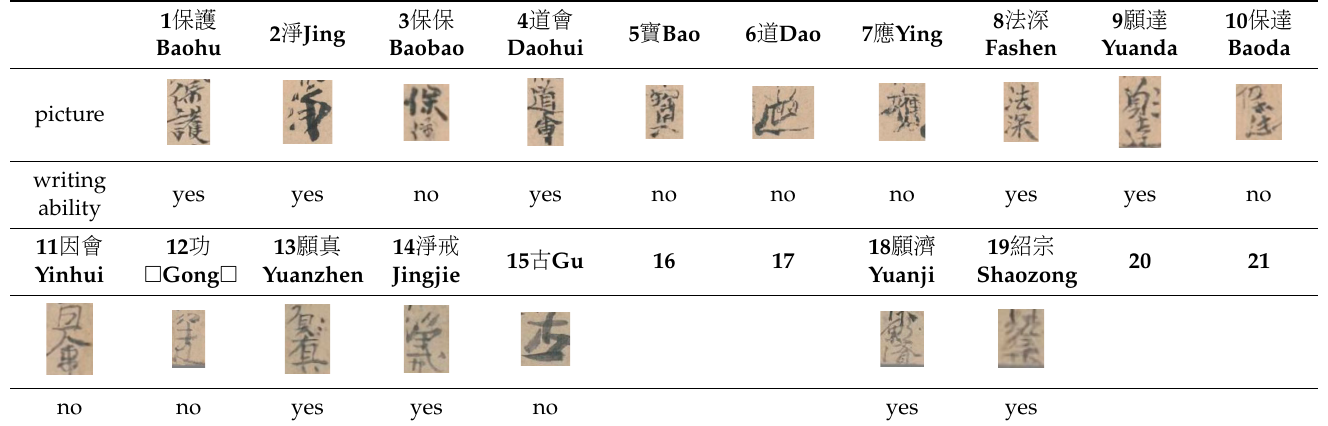
Table 4. Calligraphy of monks of Jingtu Monastery in 925.